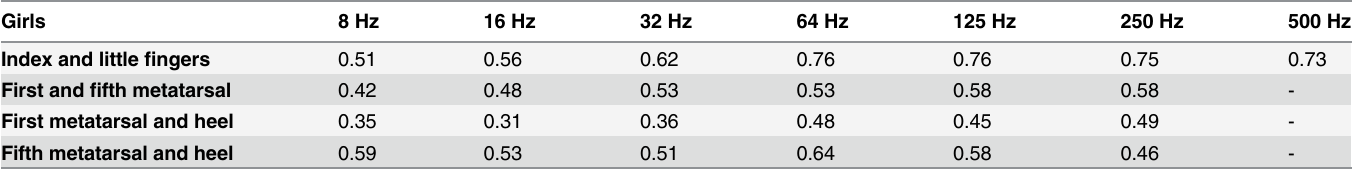
Table 7. Pearson correlation (2-tailed) between vibration perception thresholds in index and little fingers as well as between three sites in the sole of the foot at different frequencies measured in 139 healthy girls. Girls 8 Hz